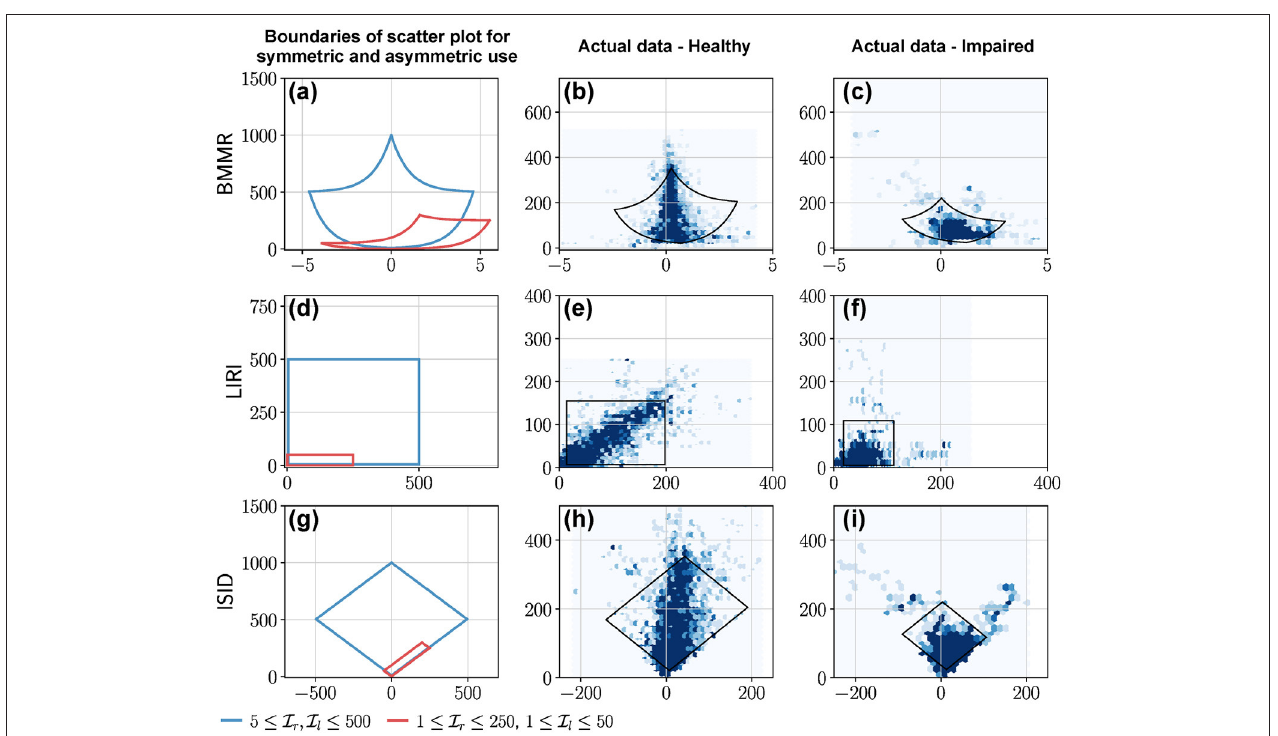
FIGURE 7 | BMMR, LIRI, and ISID plots of actual data from a healthy participant and a patient. The first column shows examples of the boundary of scatter plots for (a) BMMR, (d) LIRI, and (g) ISID plots for symmetric and asymmetric upper-limb use. This closed curve corresponds to the L 1 and L 2 curves for different values of I r and I l . (a) The symmetric leaf shape (blue) and the asymmetric (red) shape are typical shapes seen in the plots reported by Bailey et al. (2014). (b,c) Depict the BMMR scatter plots for a healthy participant and patient using data collected during a single day. (e,f) are the corresponding LIRI and (h,i) are the corresponding ISID, plots for the same subjects. The closed black curves shown in the plots for the healthy participant and patient correspond to the 2.5th and 97.5th percentiles for I l and I r .